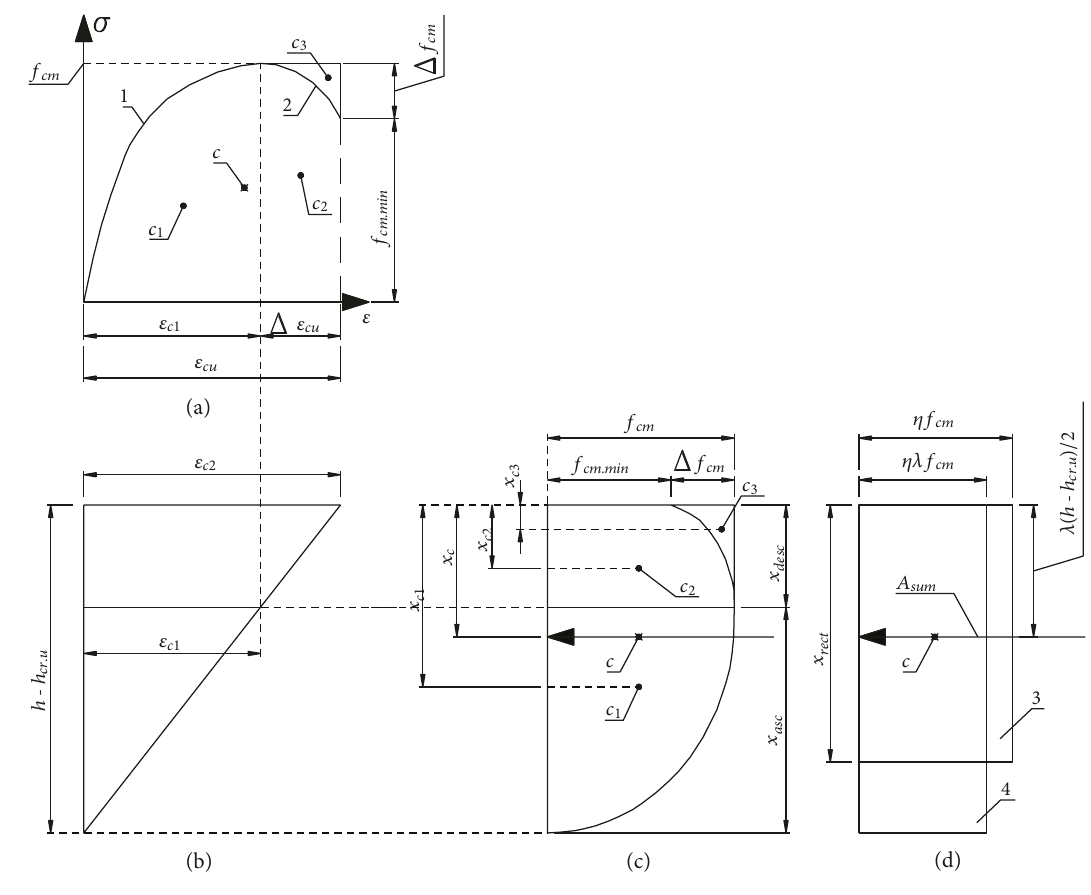
Figure 6: Stress distribution diagrams for concrete in compression: (a) curvilinear: 1 — ascending part, 2 — descending part; (b) strains in the cross-section; (c) curvilinear concrete ’ s compressive zone stress diagram and centroids of its parts: c — whole stress diagram, c — constant (rectangular) part, c part, c 2 coordinates of centroids of stress diagram parts; and (d) rectangular stress diagrams: 3 — equivalent and 4 — inequivalent [30].